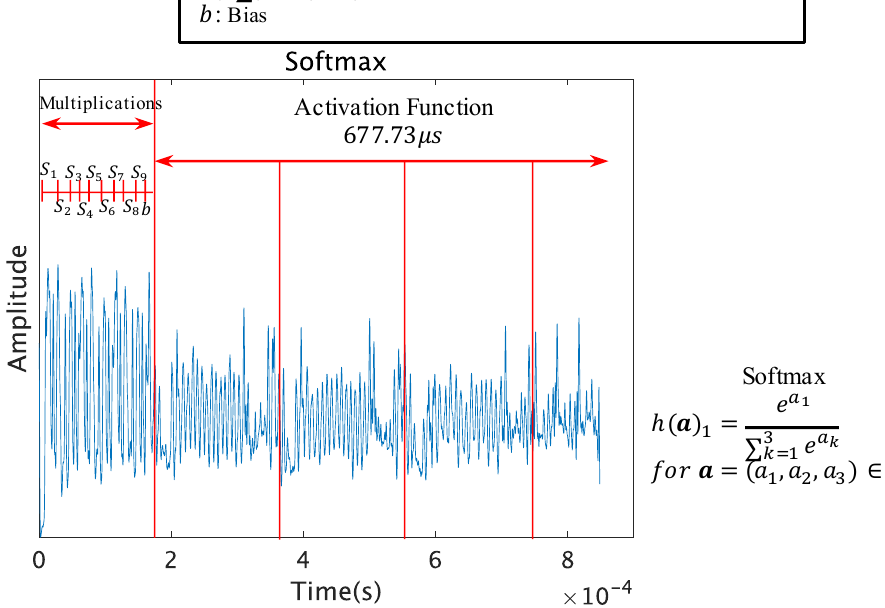
Figure 9. Processed Peak Patterns of Softmax